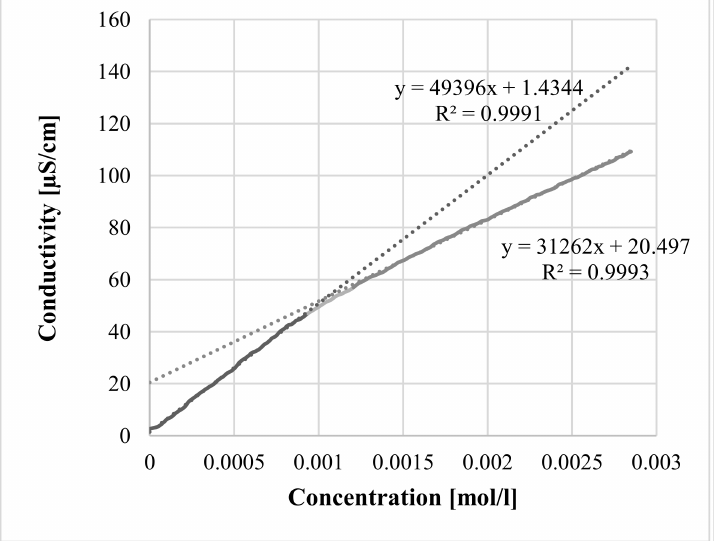
Figure 1. Dependency of conductivity on concentration. The curve was divided into three parts: lower and upper linear parts, and a transition section. The equation of the line and the coefficient of determination were calculated for both linear parts. The CMC value was determined at the intersection of both axes